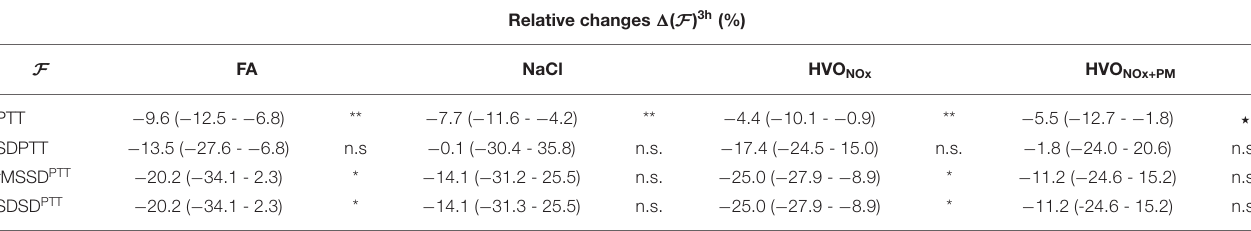
TABLE 6 | Median and interquartile range (Q 1 –Q 3 ) of relative changes 1 ( F i ) 3h in PTT features for each exposure